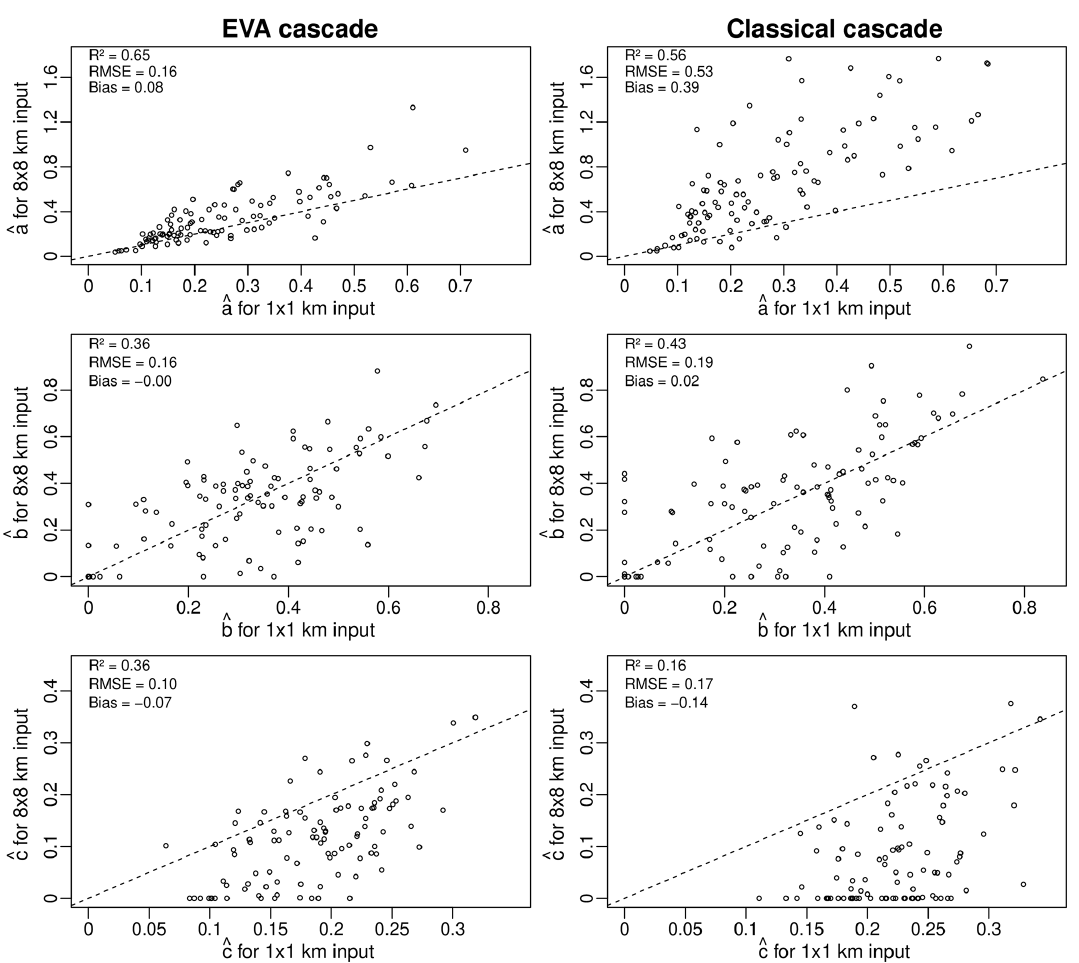
Figure 7. Estimated coarse-scale generator parameters a , b and c for an input resolution of 8km × 8km versus the fine-scale parameter values derived using the 1km × 1km data for the 100 selected